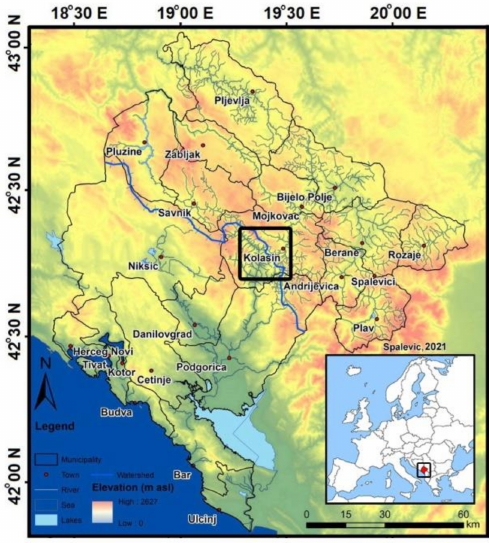
Figure 1. Study area: Kolasin, Montenegro,